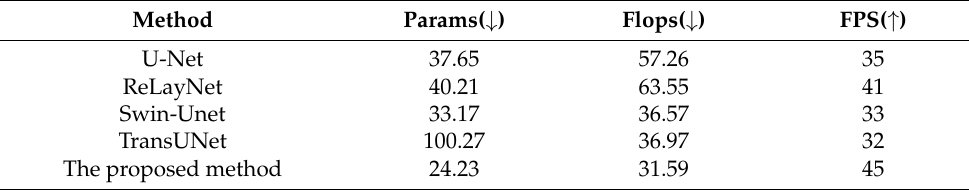
Table 6. Speed comparison of different algorithms.